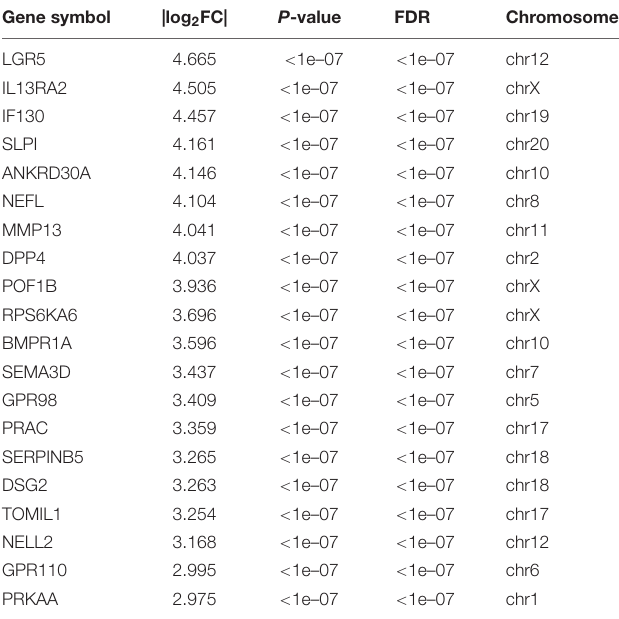
TABLE 1 | The list of top 20 differentially up-regulated mRNAs arranged from large to |log 2 FC| values. Gene symbol |log 2 FC|